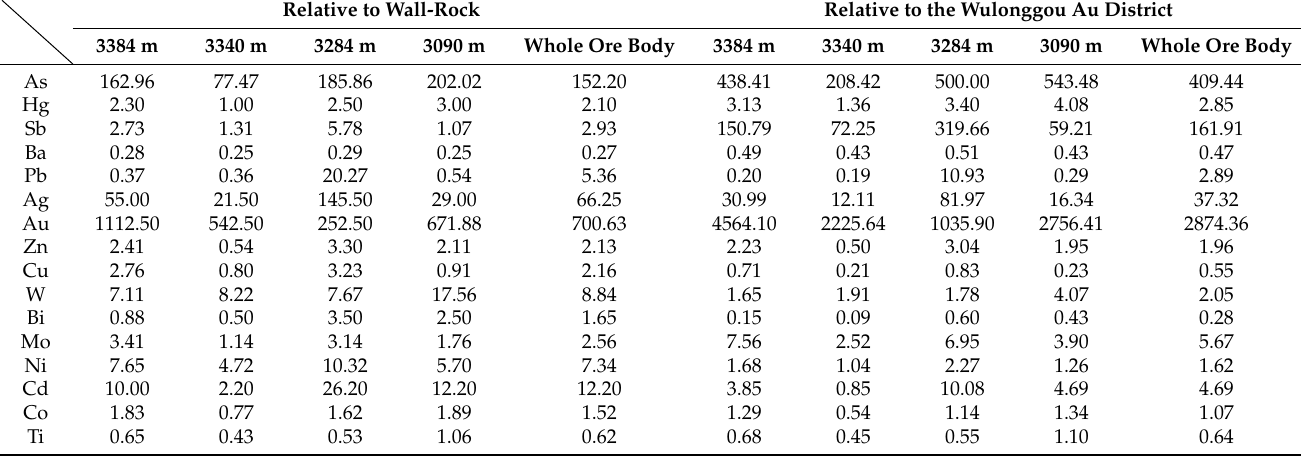
Table 4. Element anomaly for the four elevations in the Yanjingou Au